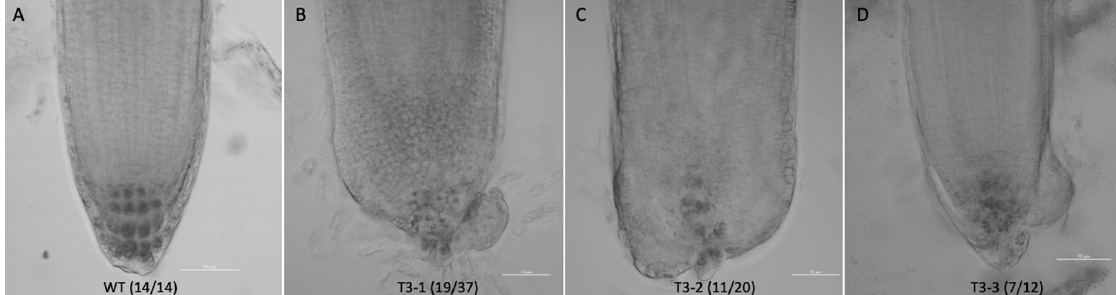
Figure 6. Root morphology of Arabidopsis p35S: LhWOX5 . The roots of 5–7 days seedlings were an-